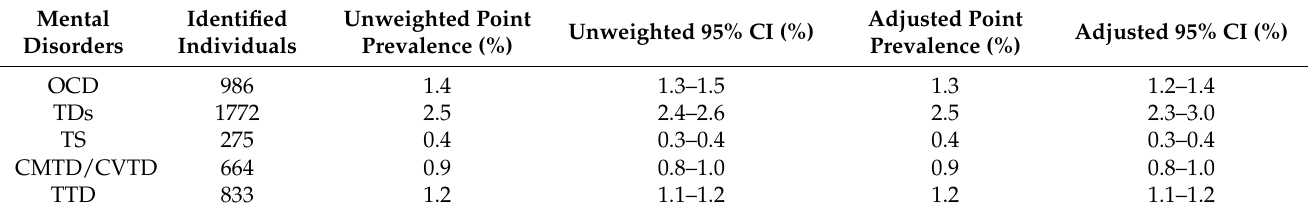
Table 1. The prevalence of OCD and TD in children aged 6–16.